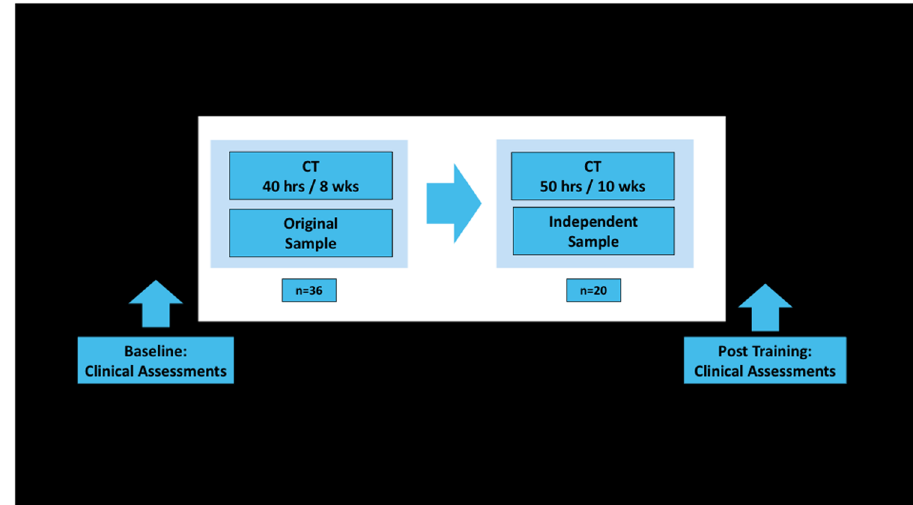
Fig. 2 Training design of the original and independent validation samples. The machine learning support vector model reliably predicted GAF ≥ 45 vs. GAF < 45 in SCZ participants in response to auditory-based cognitive training (CT) at the single-subject level in both